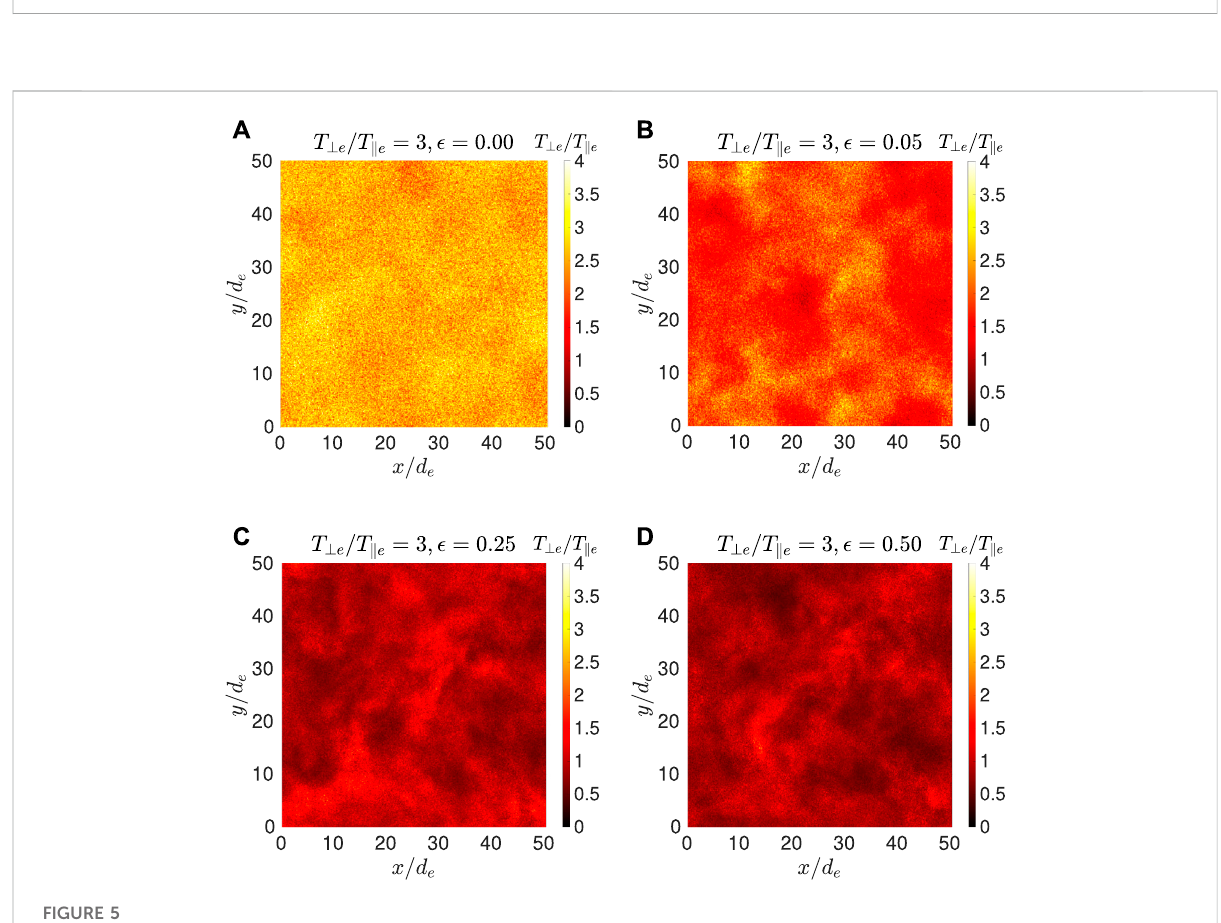
FIGURE 5 Contours of R e ( i , j , k ) on an x-y plane in the middle of the simulation box at time Ω e t ≈ 223.60 for Run D1 (A) , D2 (B) , D3 (C) , and D4 (D) .